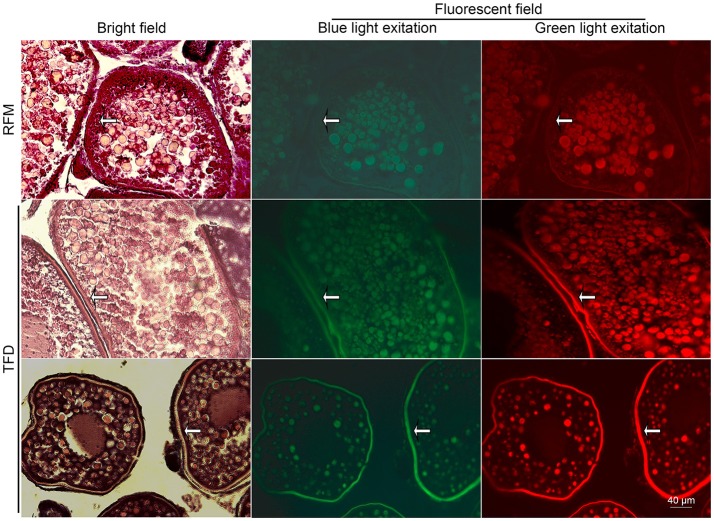
Autofluorescence of the ovarian HE stained sections in bright and fluorescent fields. White arrows represent the strengthen autofluorescence patterns in the follicle walls. Scale bars, 40 μm.